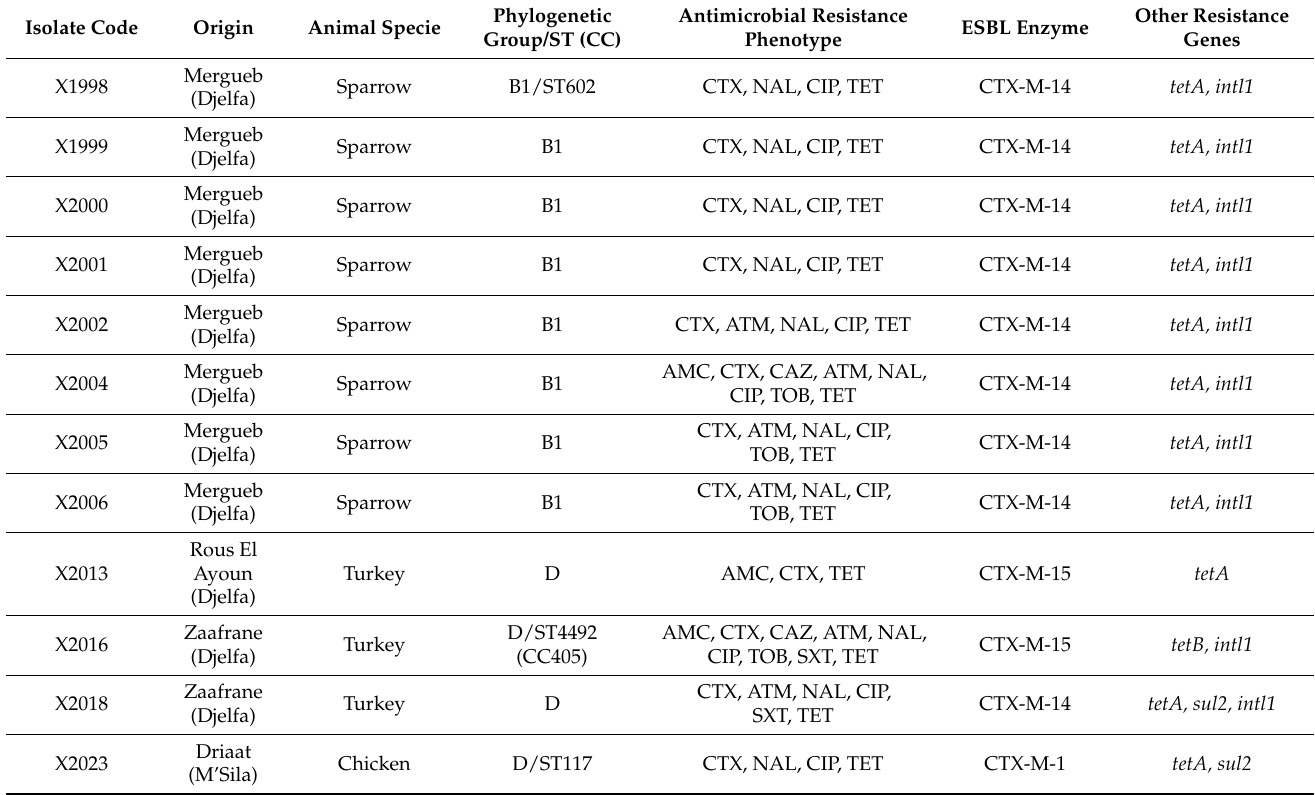
Table 1. Phenotypic and genotypic characteristics of the 12 ESBL-producing E. coli isolates recovered of sparrow, turkey and broiler faecal